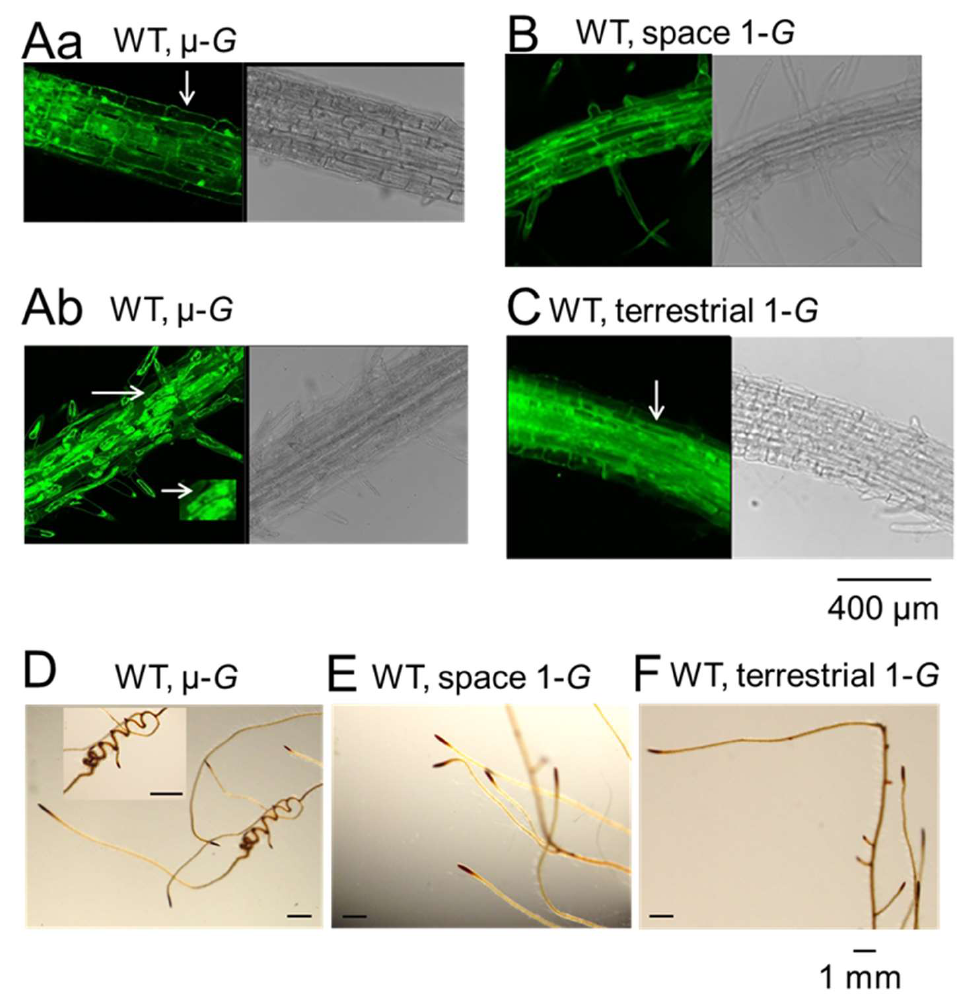
Figure 2. Confocal images and Lugol’s iodine staining of WT-MCA1-GFP in roots. ( Aa ) A sample under micro- G conditions; near the root tip (upper panel Aa ) and a part closer to the base of the root (lower panel Ab ); ( B ) under artificial 1- G conditions generated by centrifugation in ISS; C, under 1- G conditions on the terrestrial conditions. The arrow in ( Aa ) (upper panel) shows the plasma membrane, and that in the lower panel ( Ab ) shows cytolysis (majority of cells show cytolysis), and that in ( C ) shows the plasma membrane. The root in panel ( B ) was a few centimeters from the root tip. Dissociation of the cell membrane from the cell wall was used as a sign of cytolysis. Typical cell cytolysis is shown in the inset of ( Ab ) (see the arrow). The pattern of the Lugol’s iodine staining of the WT root under micro- G ( D ) and 1- G ( E ) terrestrial 1- G ( F ). The root coil magnified is shown in the inset ( D ).